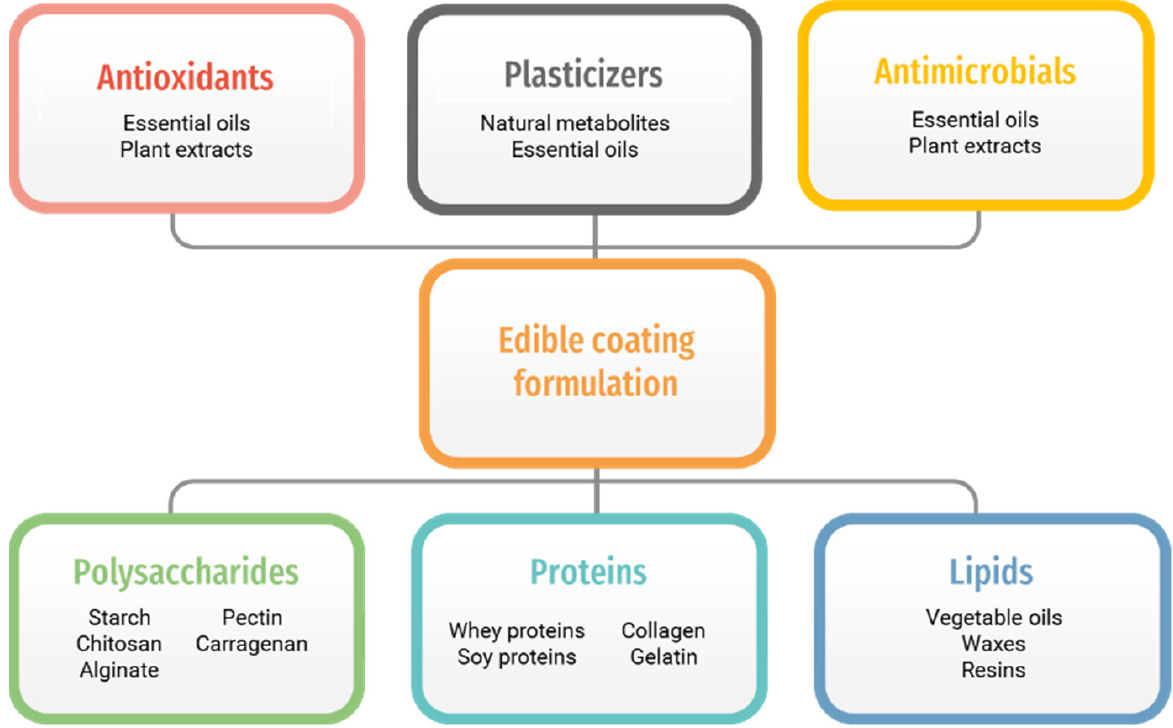
Figure 1. The main components of the edible coating formulations.